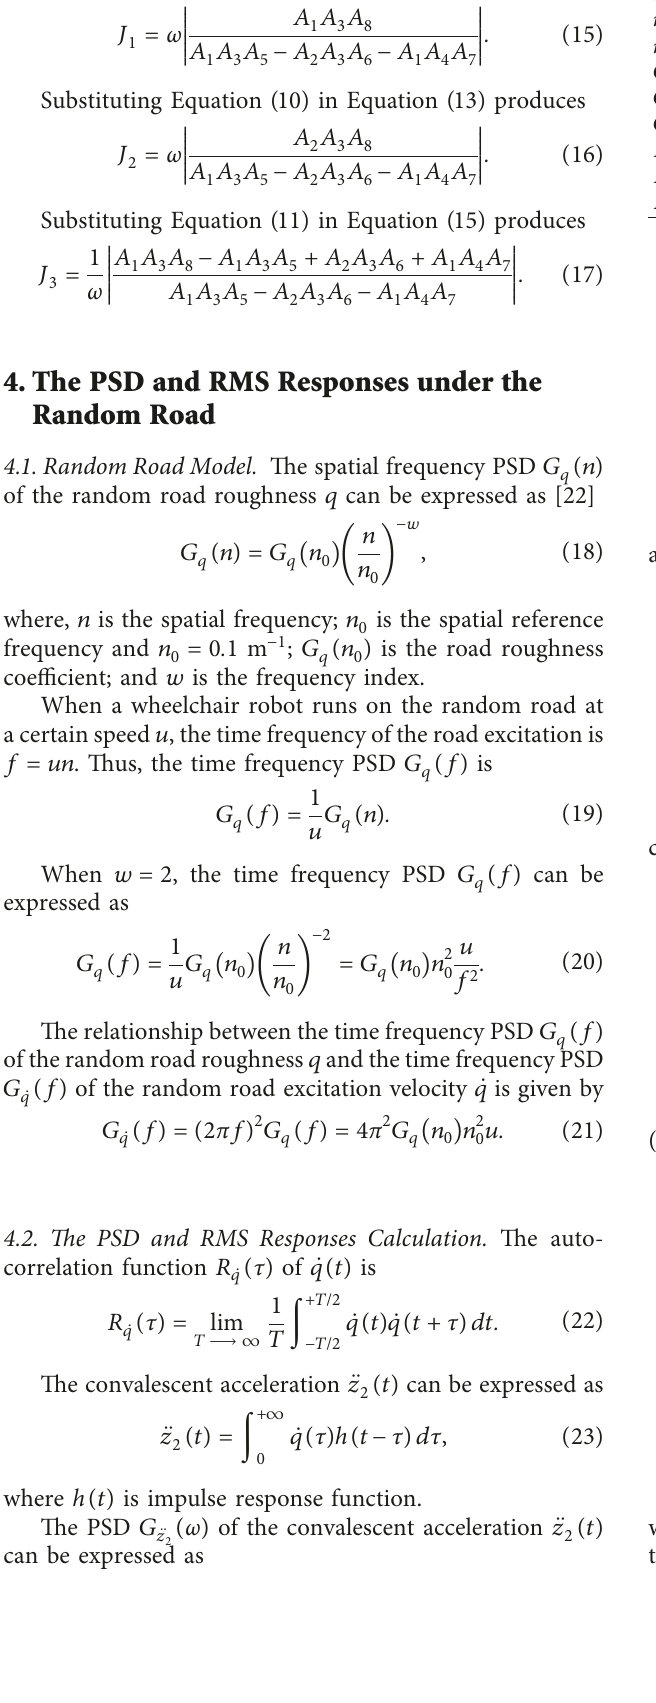
Table 1: The values of the parameters for the convalescent- wheelchair system.